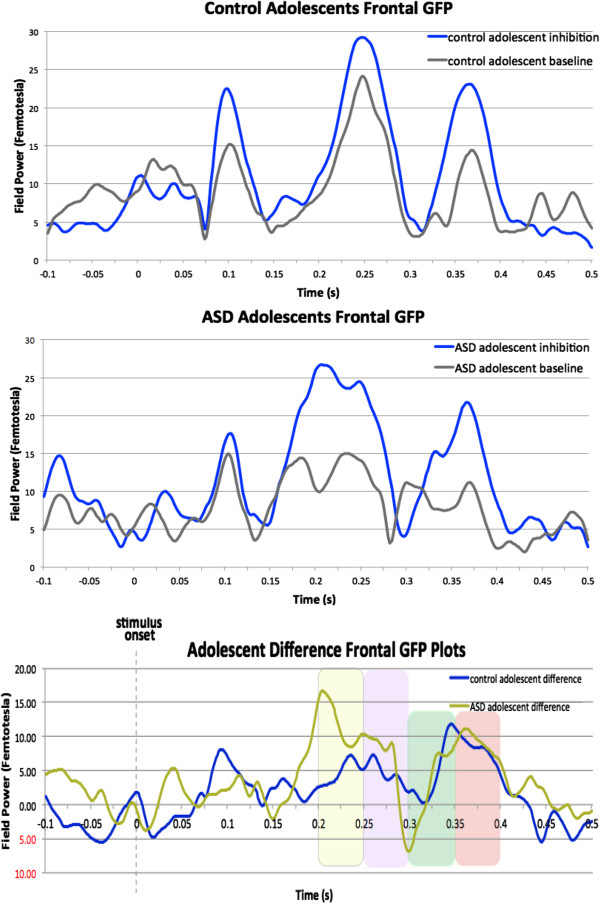
Global field power plots from frontal sensors. Upper plots: Global field power (GFP) plots from the frontal magnetoencephalography (MEG) sensors for the inhibition trials for the two conditions in the control adolescents (top plot) and the adolescents with autism spectrum disorder (ASD) (middle plot). Lower plot: Difference waveforms for Global field power (GFP) between the inhibition and baseline conditions, measured by MEG sensors over the frontal area of the brain on correct no-go trials for the two groups: control (blue) and ASD (gold). Stimulus onset is marked at 0 seconds. Four 50 ms time windows of interest are marked.